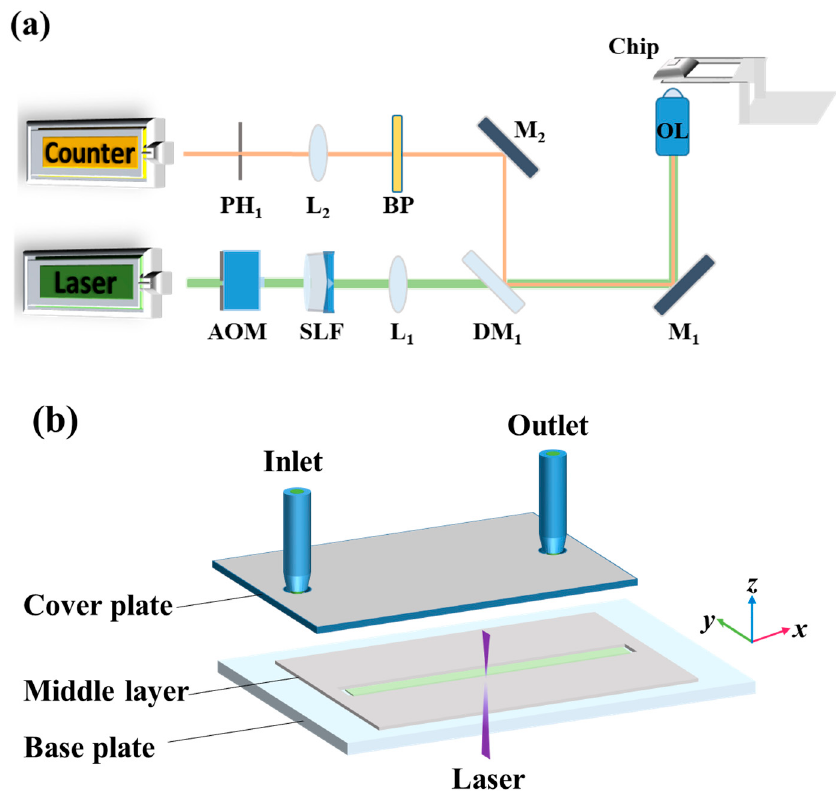
Figure 1. Experimental setup. ( a ) Schematic diagram of LIFPA experimental system based on confocal microscope; ( b ) schematic diagram of microchip.